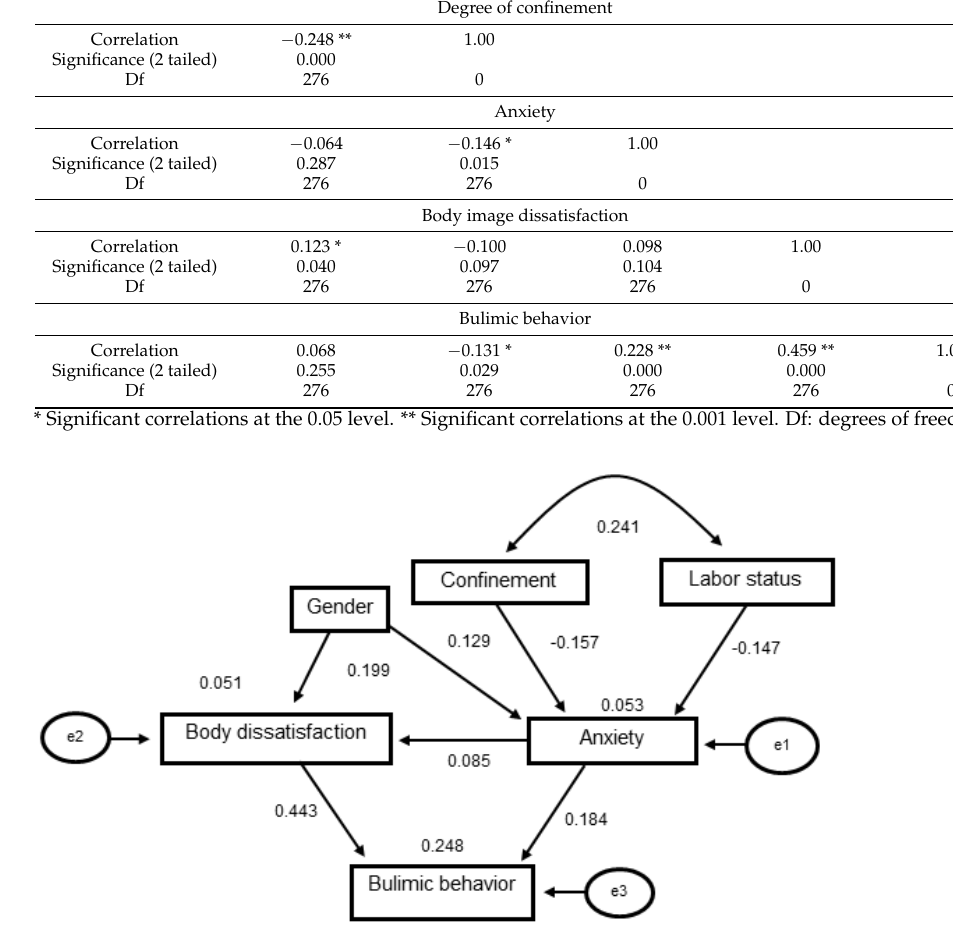
Figure 2. The bulimic behavior model explained from anxiety and body dissatisfaction. Body dissatisfaction is explained from anxiety and gender. Anxiety is explained from confinement and labor status. The rectangles represent the observed variables; the ovals represent the errors associated with the endogenous variables: e1 is the measurement error for anxiety; e2 for body dissatisfaction and e3 for the bulimic behavior.